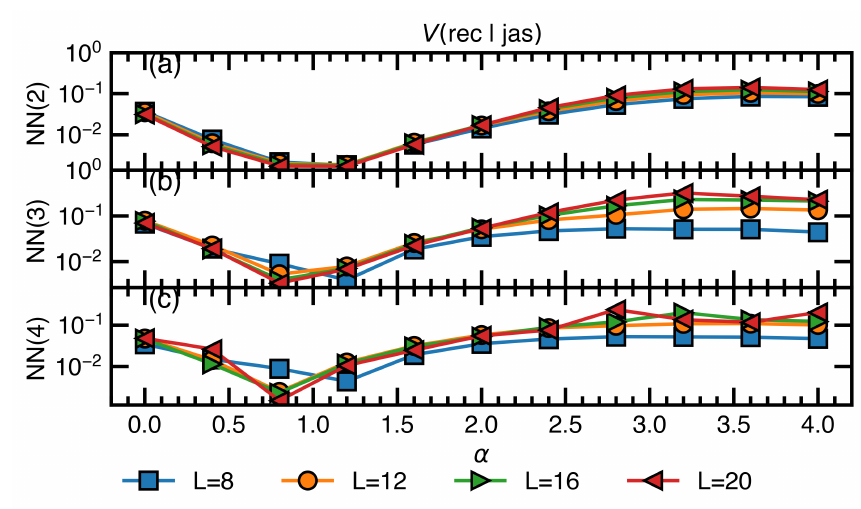
Figure 11: Norm of the cumulative correlation difference V ( rec | jas ) , defined in Eq. (45), for different chain lengths L